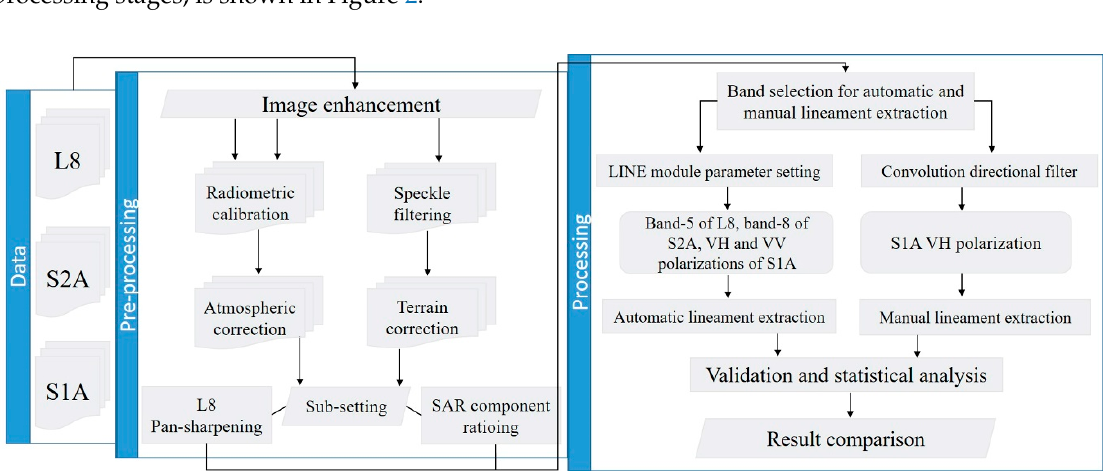
Figure 2. The methodology flowchart of the study.